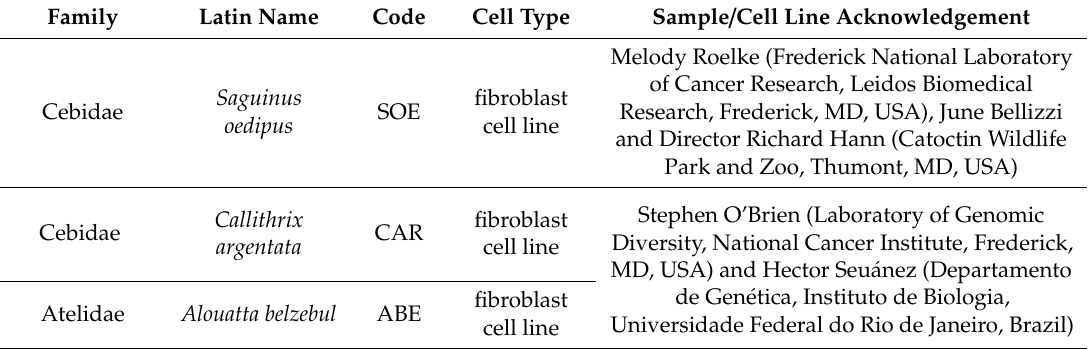
Table 1. List of cell lines used in this